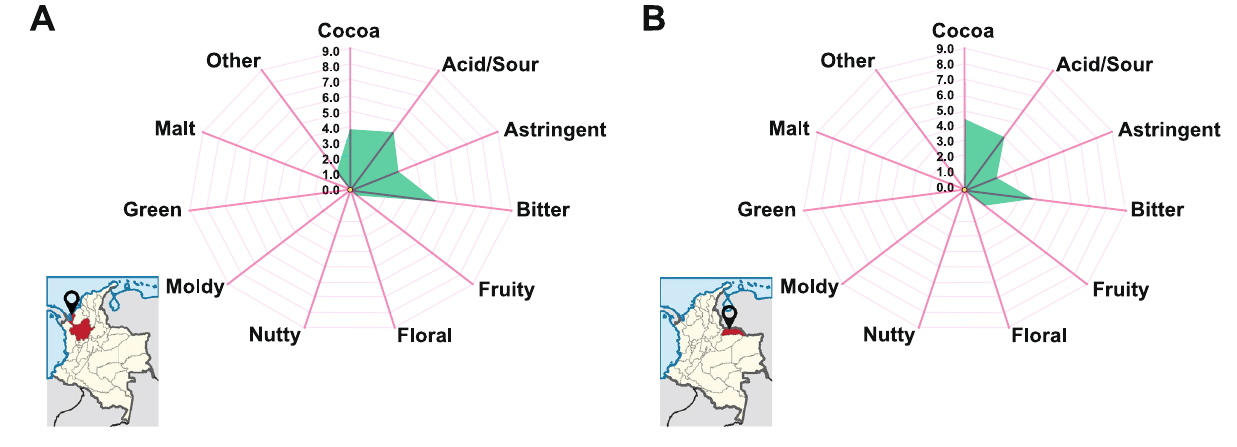
Figure 1. Sensory profiles of cocoa liquor samples produced in Colombia by CASALUKER S.A., from a mixture of commercial clones of fine-flavour cocoa beans from Necoclí ( A ) and Arauca ( B ) farms (for more details on selected clones see experimental section). The flavour intensity increases from the centre to the perimeter. Data were obtained through a sensory analysis performed by a trained tasting panel of 6 members. Three replicates were performed. Mean values are shown.